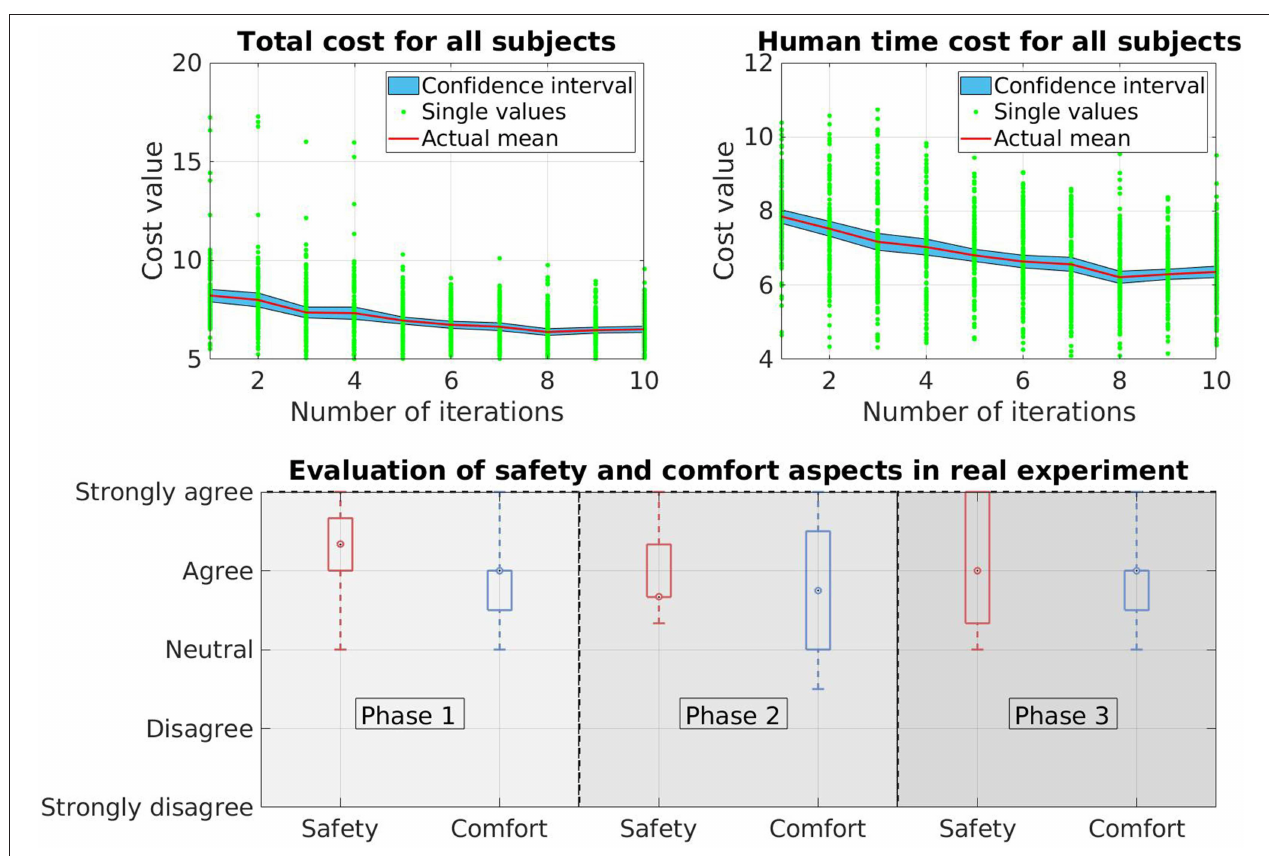
FIGURE 11 | Results of the real experiment on a KUKA LWR 4+ robot. The top side of the figure shows the total cost and human prediction time cost while the bottom side shows the human evaluation in the safety and comfort aspects when working with the real